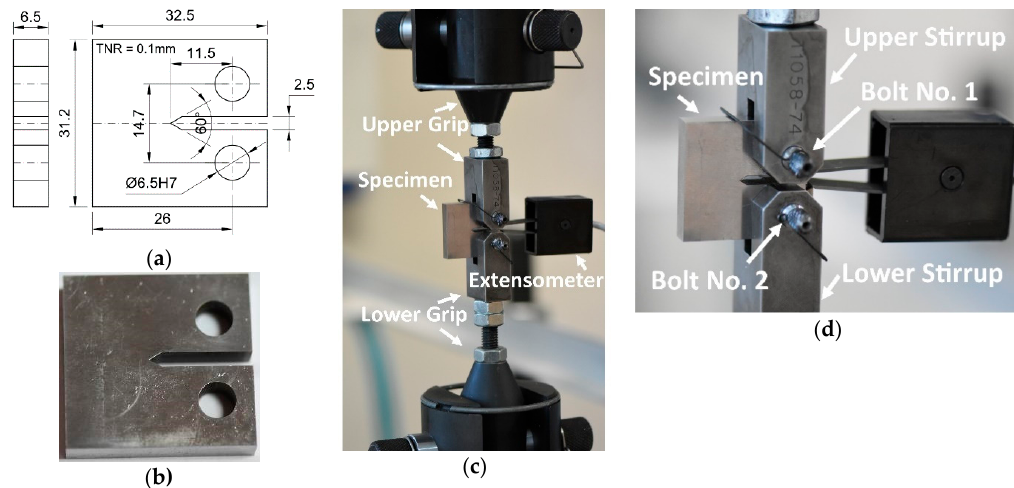
Figure 3. Compact tension (CT) mini-specimen: ( a ) engineering drawing; ( b ) after manufacturing; ( c ) and ( d ) fixed in the testing machine before experiment.